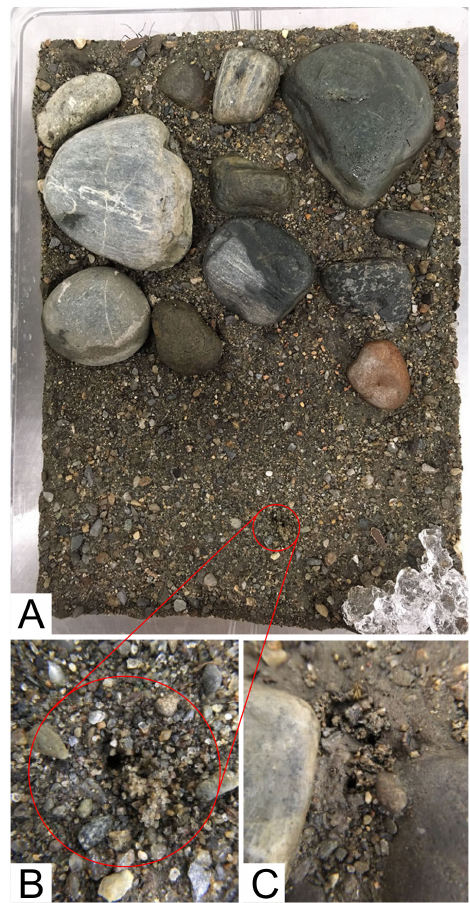
Figure 1. Overview of a rearing bin used in this study showing a mated pair of adults and the arrangement of cobbles and open area used for all bins, with detailed views of oviposition holes. ( A ) shows a view of the oviposition hole detailed in ( B ), ( C ) shows typical oviposition holes from a di ff erent bin, made at the base of, or adjacent to,